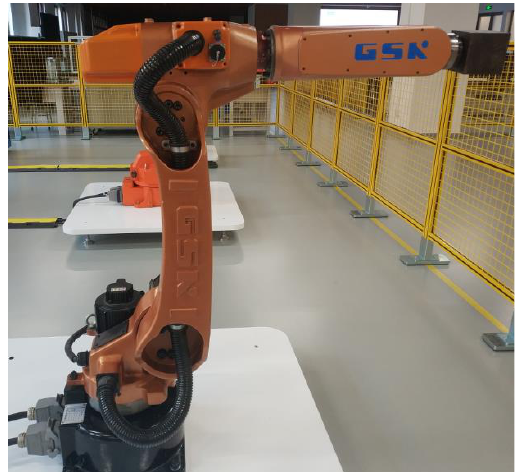
Figure 5. Industrial robot with the simulation model.